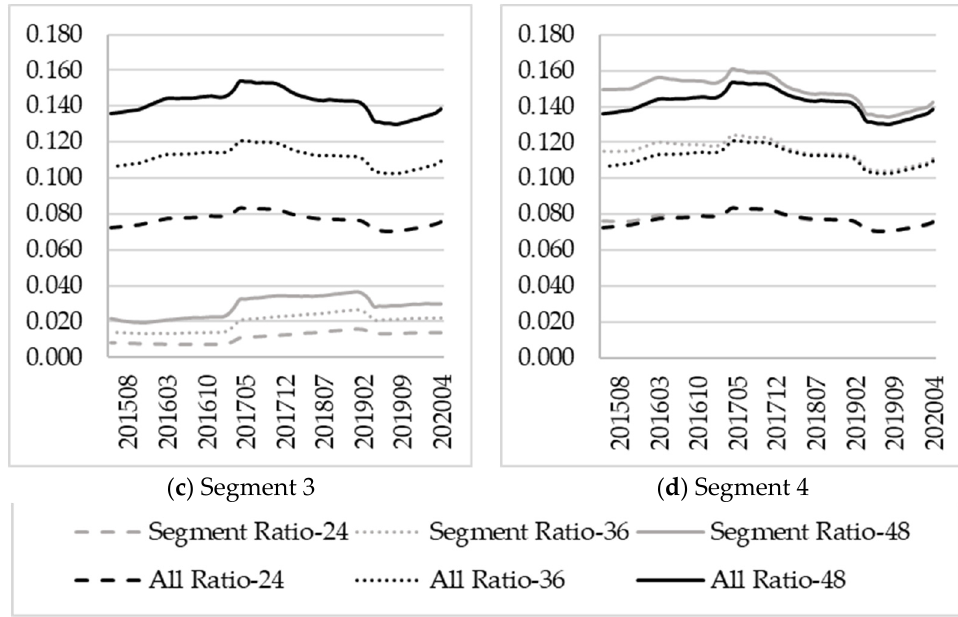
Figure 5. Cumulative segmented PDs to cumulative unsegmented PDs over different horizons.